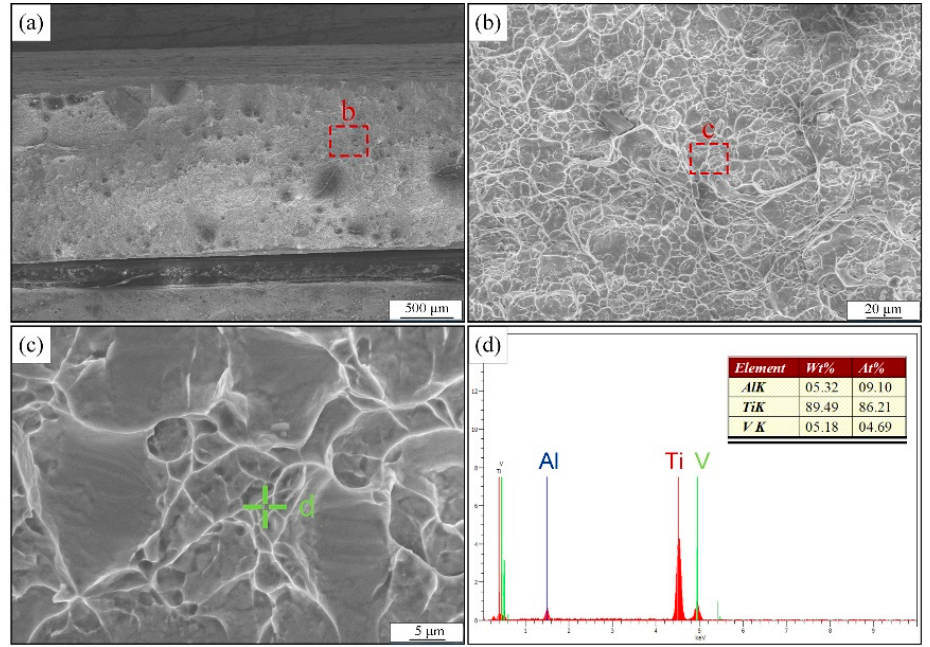
Figure 15. Fracture microscopic morphology and the composition of tensile specimens: ( a – c ) the SEM results, ( d ) the EDS result.